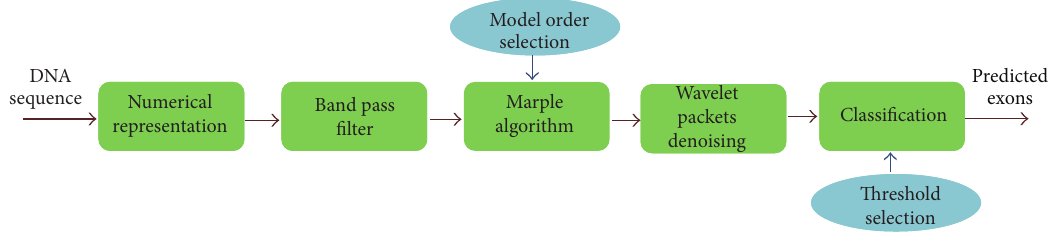
Figure 3: Block diagram of the proposed